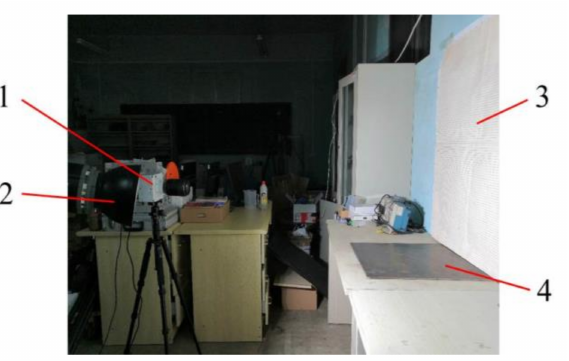
Figure 2. Ear drop test. (1) High-speed camera; (2) light supplement lamp; (3) height marker; (4) steel